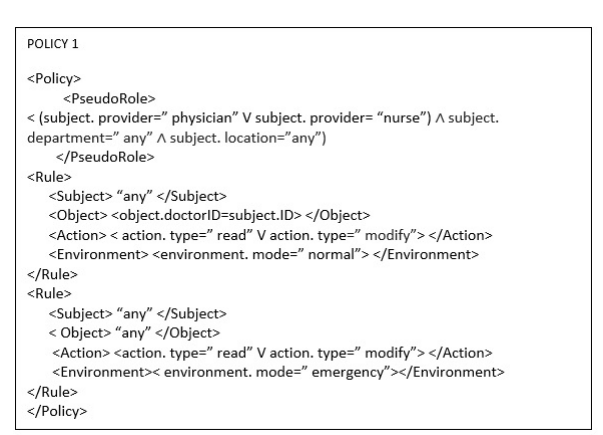
Figure 7. Policy within Clinical